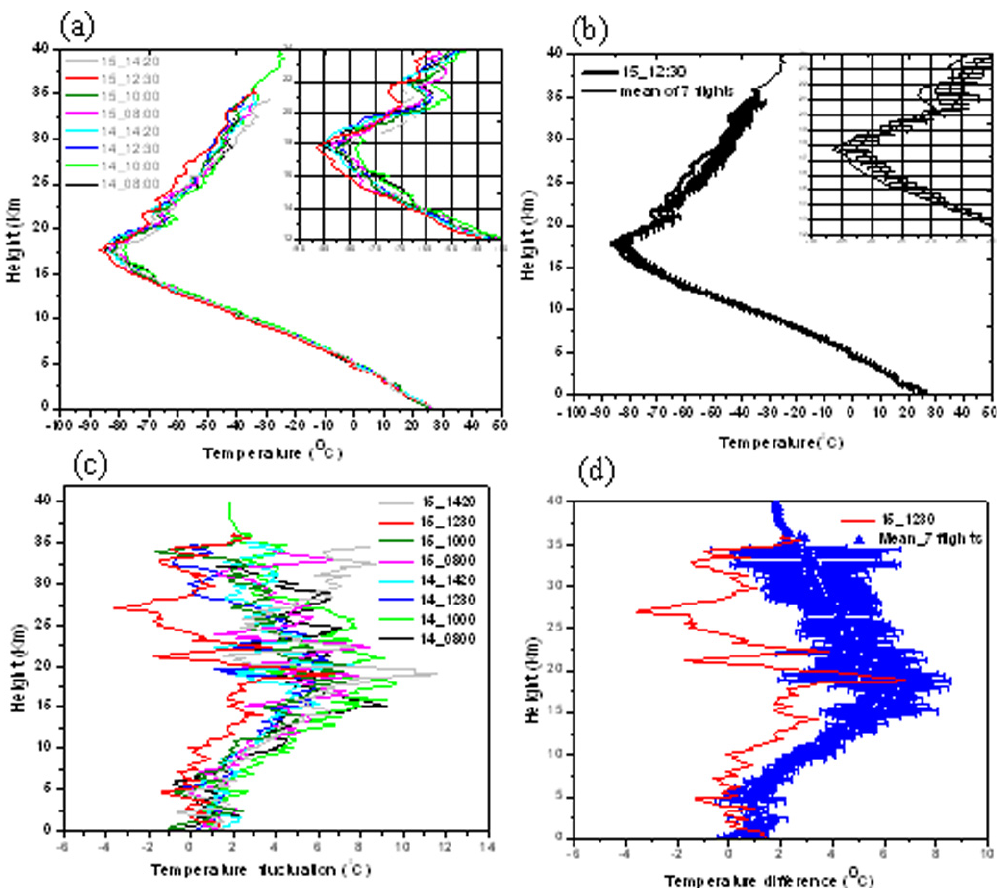
Fig. 3. (a) Height profiles of temperature at 08:00, 10:00, 12:30 and 14:20IST on 14 and 15 January 2010 with different colours. (b) Height profile of temperature during the eclipse time (12:30IST) compared with the mean of all other temperature profiles on non-eclipse timings along with standard deviations. (c) Mean-removed fluctuations on the control day (14) and eclipse day (15) of January 2010 at 08:00, 10:00, 12:30 and 14:20IST. (d) Temperature fluctuation profile at 12:30 (red) IST on the eclipse day and mean for all other fluctuation profiles along with standard